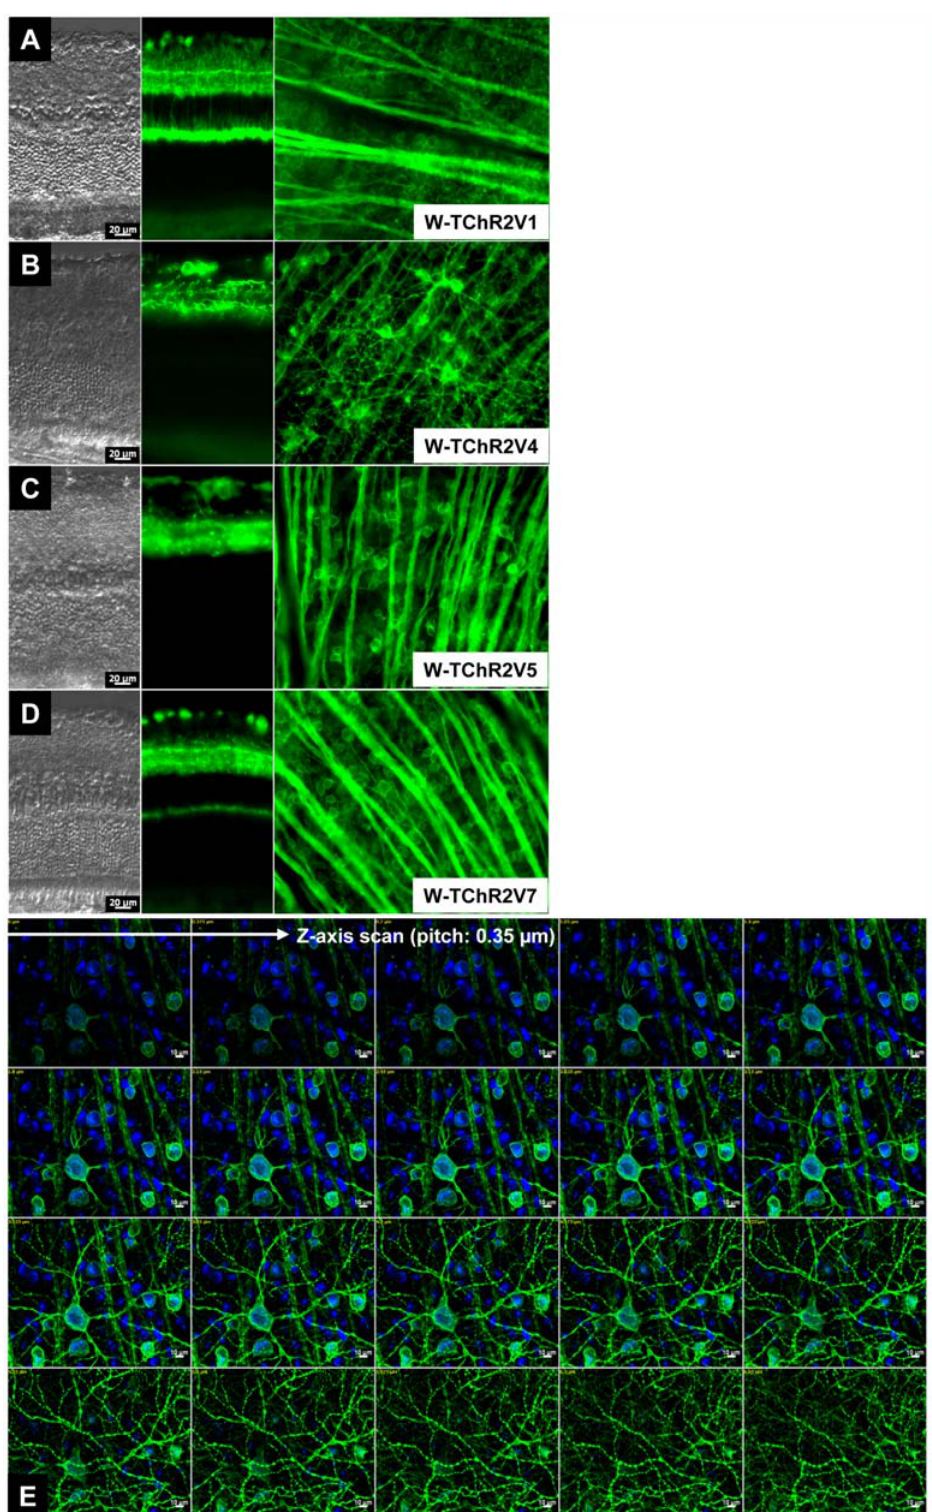
Figure 2. Microphotographs showing ChR2V expression in the inner retinal layers of each transgenic line. (A–D) The retinal organization of each transgenic line (A, W-TChR2V1; B, W-TChR2V4; C, W-TChR2V5; D, W-TChR2V7) showed normal features in the Nomarskii images (left). Fluorescence microphotography revealed various expression patterns in retinal slices (middle) and flat-mounted retinas (right). (E) Z-axis scan (pitch: 0.35 m m) images collected from a flat-mounted retina of a ChR2V + / 2 rat (line W-TChR2V4) showed that the ChR2V fluorescence (green) was coexpressed with fluorogold transported retrograde from the superior colliculus (blue).